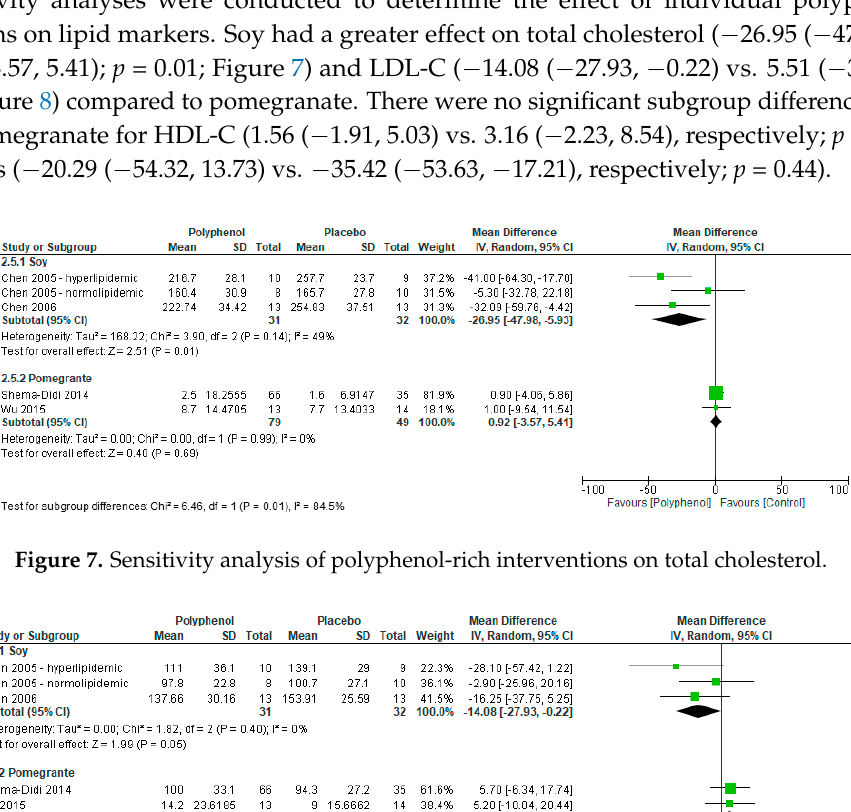
Figure 8. Sensitivity analysis of polyphenol-rich interventions on LDL-C.